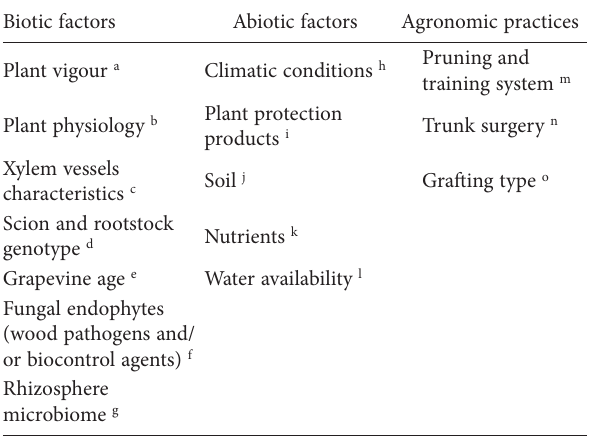
Table 1. Biotic and abiotic factors and agronomic practices corre- lated to esca leaf stripe symptoms in